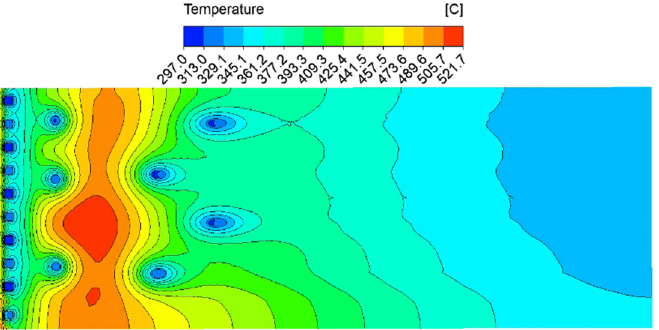
Figure 7. Temperature contour at the interface between the top radial–toroidal plate and PbLi do ‐ main.